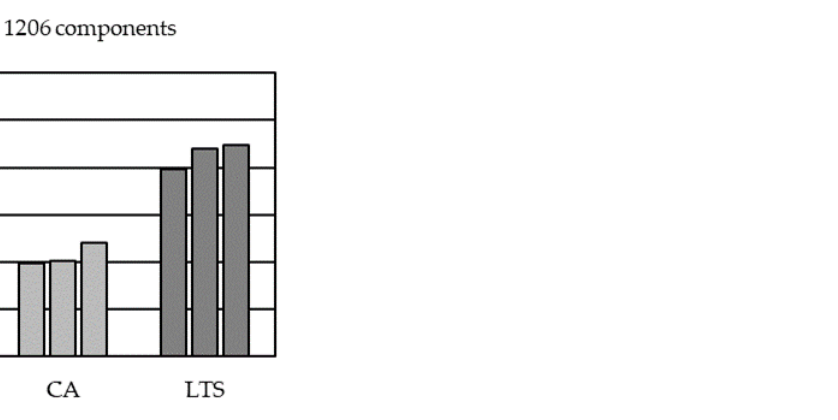
Figure 14. Shear load at break for 1206 components using CA or LTS to mount the copper pads.